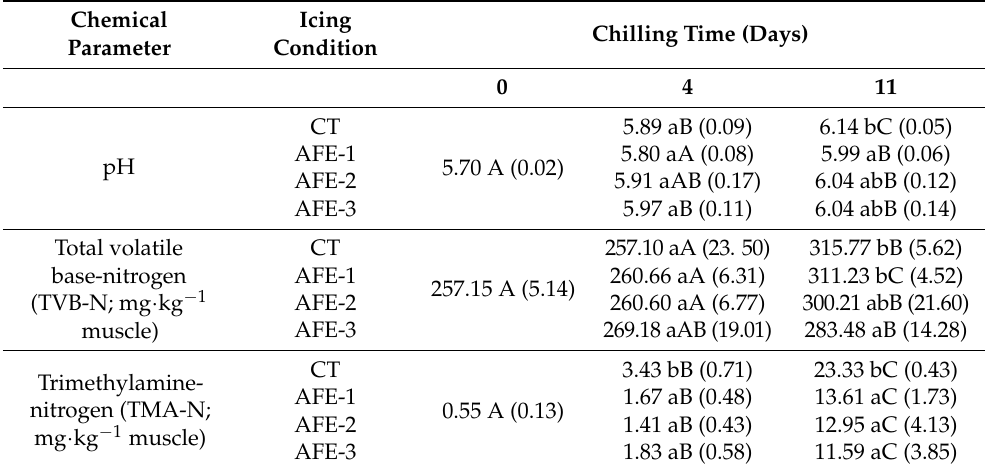
* Mean values of three replicates ( n = 3); standard deviations are indicated in brackets. Mean values followed by different lowercase letters (a, b) denote significant differences ( p < 0.05) as a result of storage temperature; mean values followed by different capital letters (A–C) denote significant differences ( p < 0.05) as a result of storage time. ** Icing conditions (CT, AFE-1, AFE-2, and AFE-3) as expressed in Figure